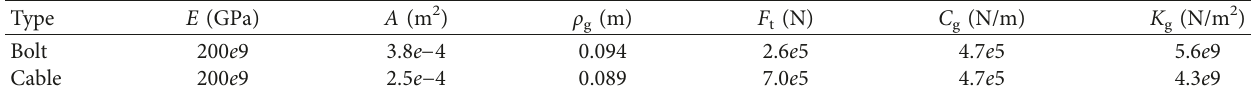
Table 2: Relevant parameters of the cable structural element.